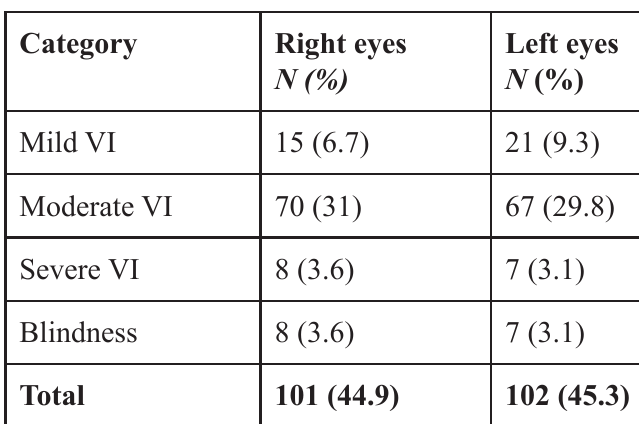
Table 2: The categories and prevalence of compensated visual impairment (VI) and blindness in the right and left eyes of the participants (After optical compensation, 124 and 123 of the right and left eyes respectively did not have VI and blindness).